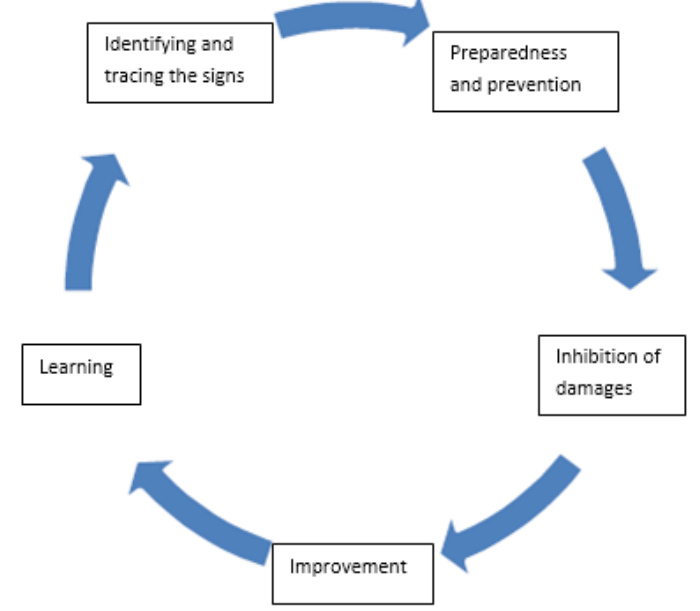
Fig 1. Tiri and Mitraf model (Mehr and Jahanyan, 2016)